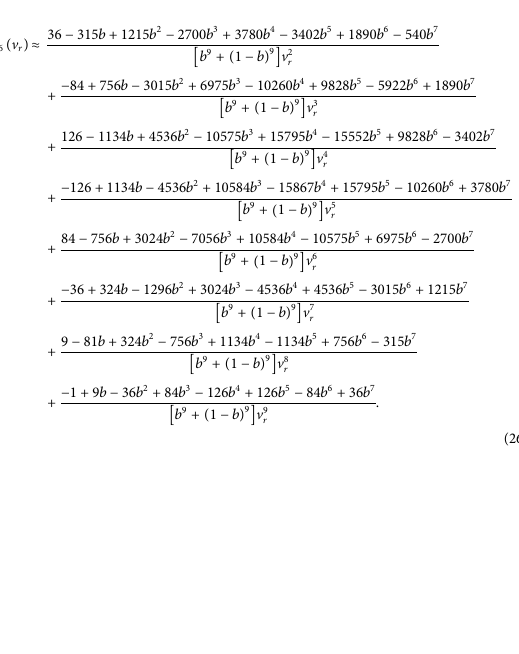
Choosing χ from the experimental data, we obtained n = 4 Janus van der Waals equations for nine molecules,